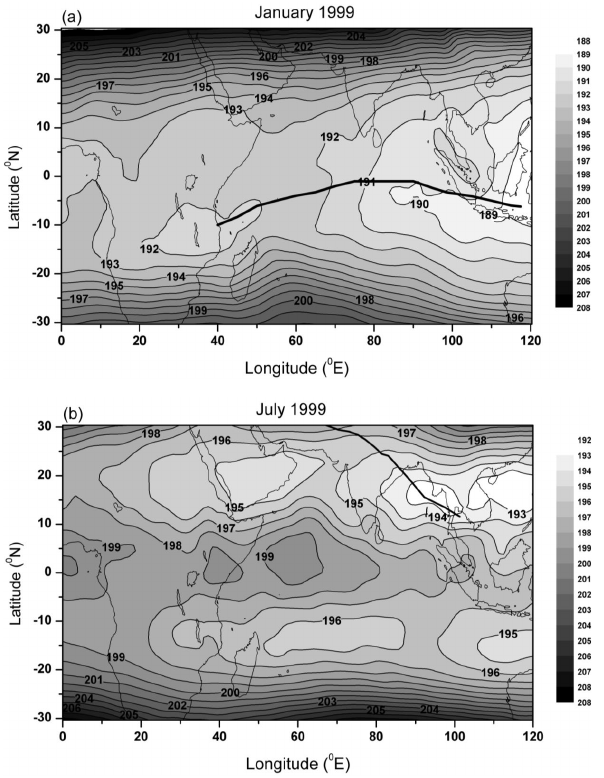
Figure 2. Fig. 2. Plot of contour maps of monthly mean temperature field at 100hPa level from ECMWF reanalysis. Solid line shows location of ITCZ as determined using monthly mean OLR distribution from satellite INSAT-1D. (a) January 1999, (b) July 1999.